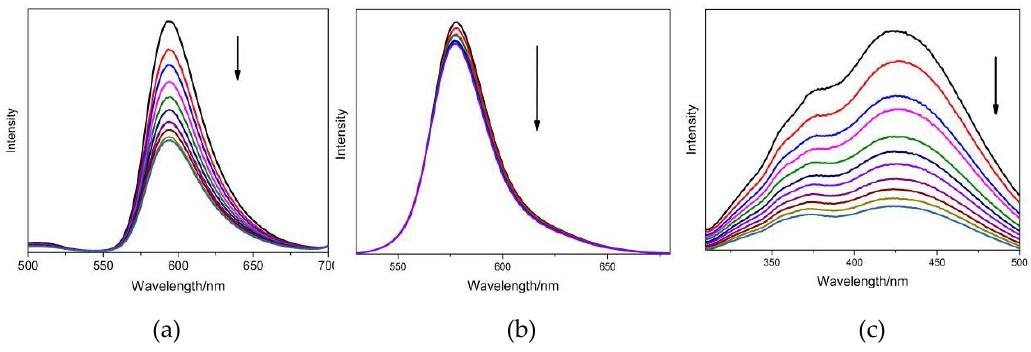
Figure 9. The emission spectra of ( a ) FB, ( b ) BR2 and ( c ) VBB under different concentrations of CT-DNA. The arrows indicate the spectra change of dyes with the addition of CT-DNA at different concentrations for 0 ( — ), 2 ( — ), 4 ( — ), 6 ( — ), 8 ( — ), 12 ( — ), 16 ( — ), 18 ( — ), and 20 ( — ) μ M. ( n = 3).